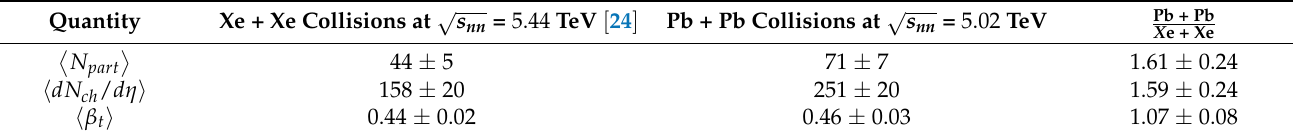
Table 6. The threshold border values of analysis for Pb + Pb collisions at study [24] for Xe + Xe collisions at two collision types are presented in the last